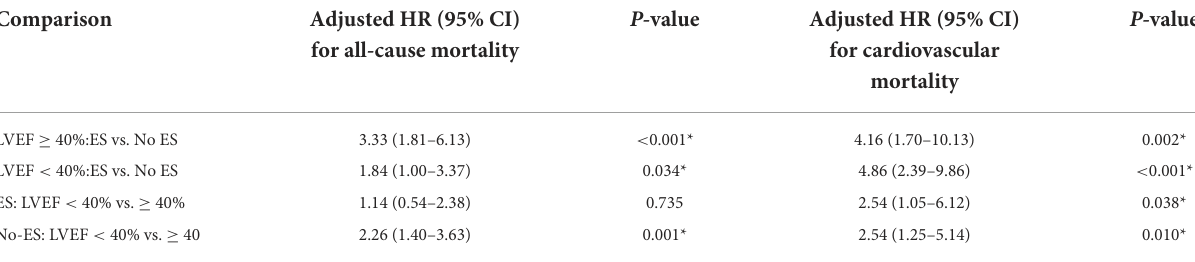
TABLE 5 Selected comparisons among subgroups.